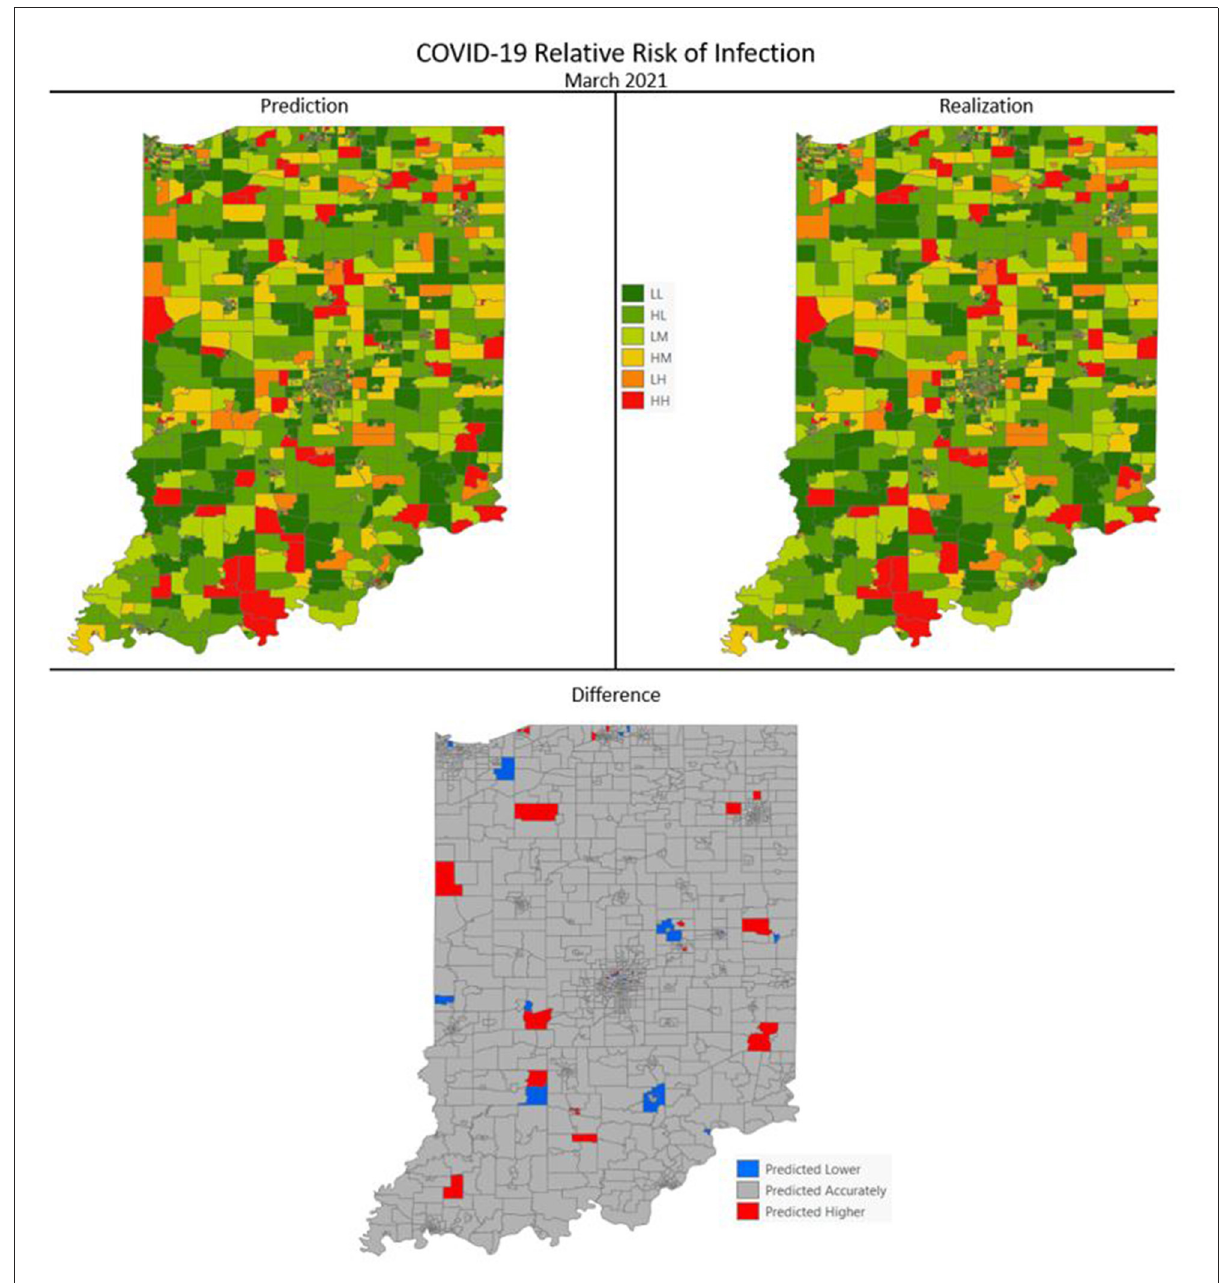
FIGURE8 COVID-19 categorical relative risk of infection prediction and realization for March